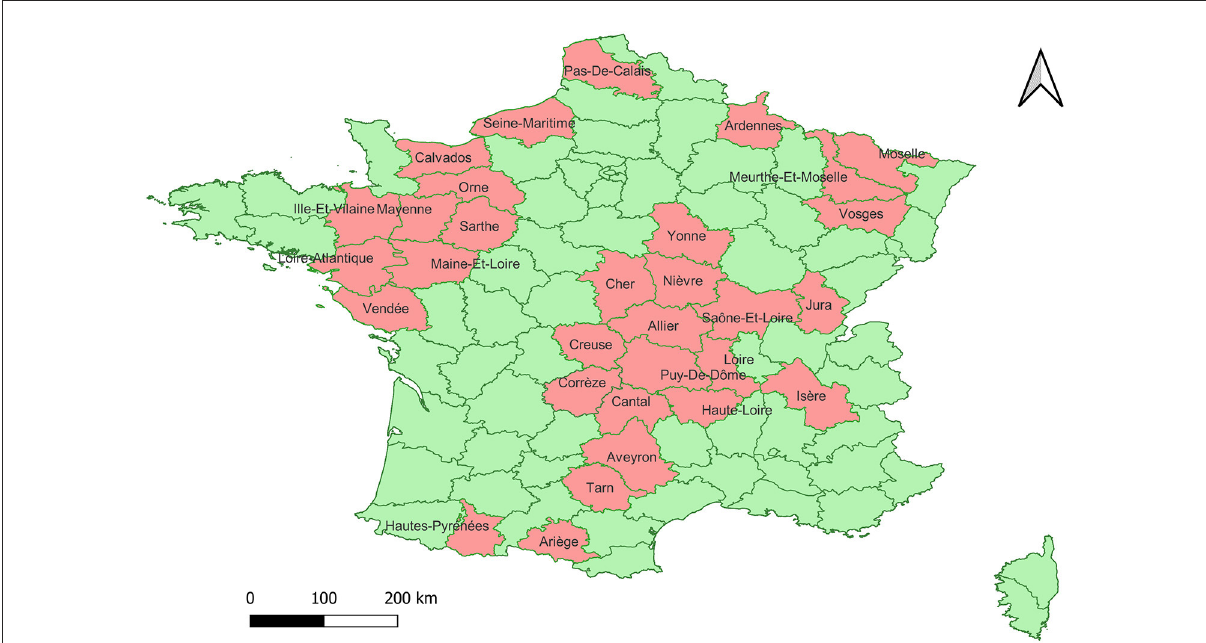
FIGURE1 Map of the geographic distribution of the collection sites of the 146 samples included in the study. In pink the departments from which the samples have been collected.